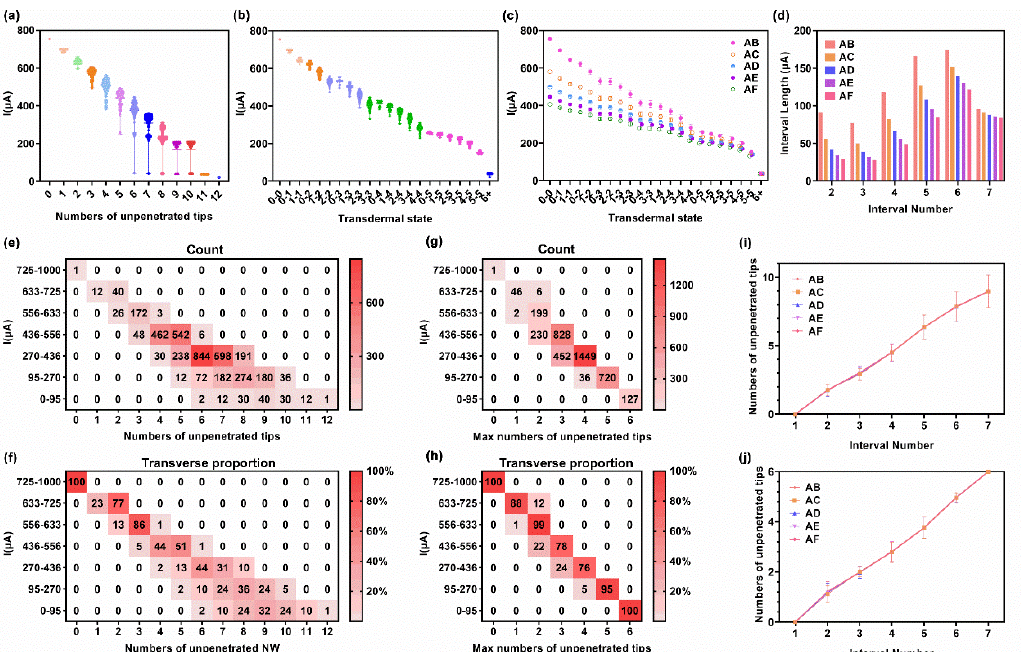
Figure 6. Simulation results of the 6 × 6 microneedle array model, obtained from the statistical analysis of the terminal current after sweeping 4096 transdermal events per pair of microneedle sheets. ( a ) The nested figure of the current distribution of A-B inter-sheet, divided by N total . ( b ) The nested figure of the current distribution of A–B inter-sheet, divided by the transdermal state. ( c ) The statistical results of the test current against the transdermal state. ( d ) Histogram of the interval length of each interval. The x–axis started at interval 2 on account of that the interval 1 was half open. ( e ) The counting heat map of the current interval against the N total of A–B inter–sheet. ( f ) The percentage heat map of the current interval against the N total of A–B inter-sheet. The numerals in each cell referred to the probability of N total in certain current intervals. ( g ) The counting heat map of the current interval against the N max–s in a single sheet of A-B inter-sheet. ( h ) The percentage heat map of the current interval against the N max–s of A-B inter–sheet. The numerals in each cell referred to the probability of N max–s in certain current intervals. ( i ) The statistical results of the N total of each interval in the A–B inter–sheet. ( j ) The statistical results of N max–s in a single sheet of each interval in the A–B inter–sheet. Table 3. The current interval division of the transdermal state of the 6 × 6 microneedle array model.